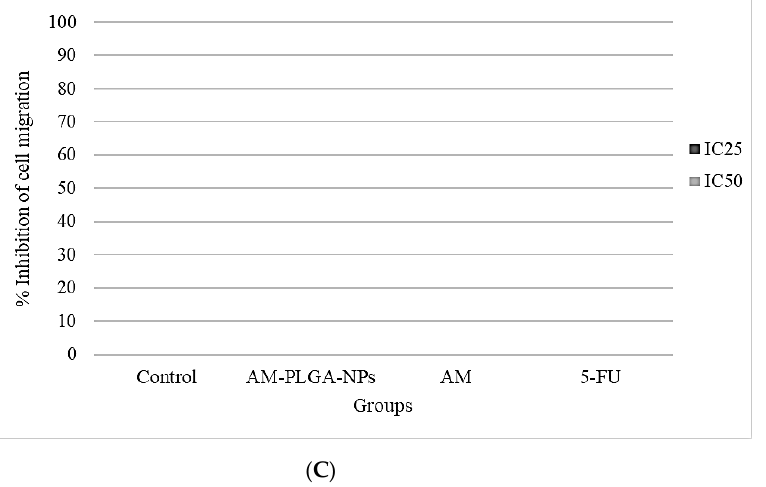
Figure 4. Inhibitory effects on the migration of ( A ) HuCCT-1, ( B ) CL-6, and ( C ) OUMS-36T-1F cell lines following the exposure to the AM-PLGA-NPs, blank PLGA, free AM, and 5-FU for 72 h. Data presented as median (range) of the triplicate experiments.